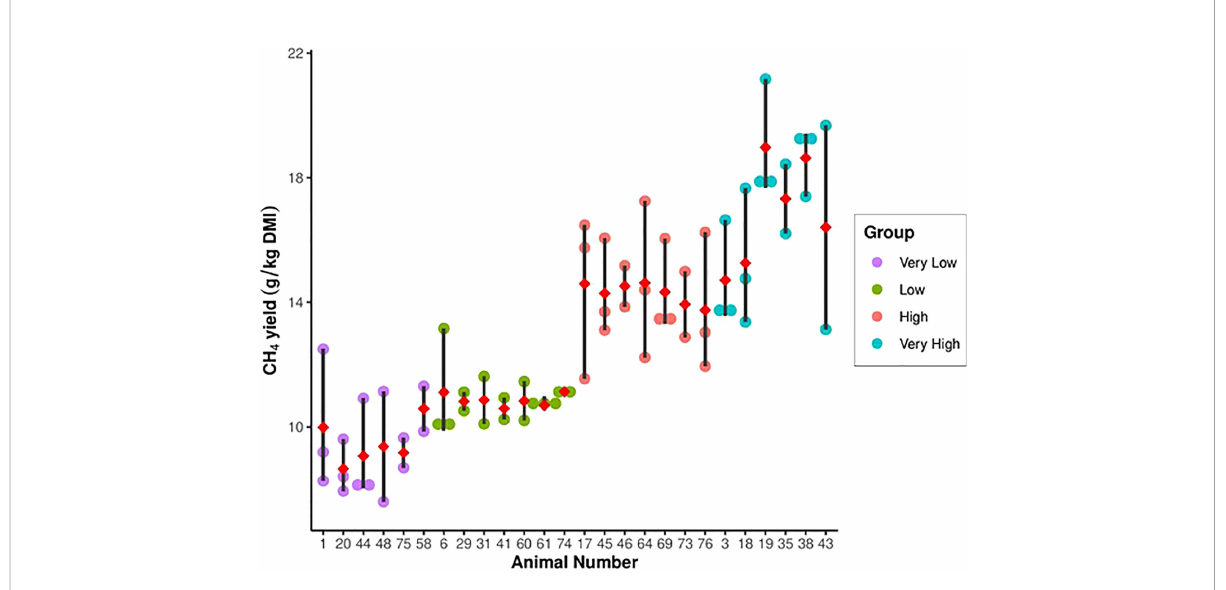
FIGURE 2 Methane (CH 4 ) yield for animals ranked as very-high, high, low and very-low emitters during the study (intermediate animals not shown). Closed circles indicate period measurements, diamond indicates the